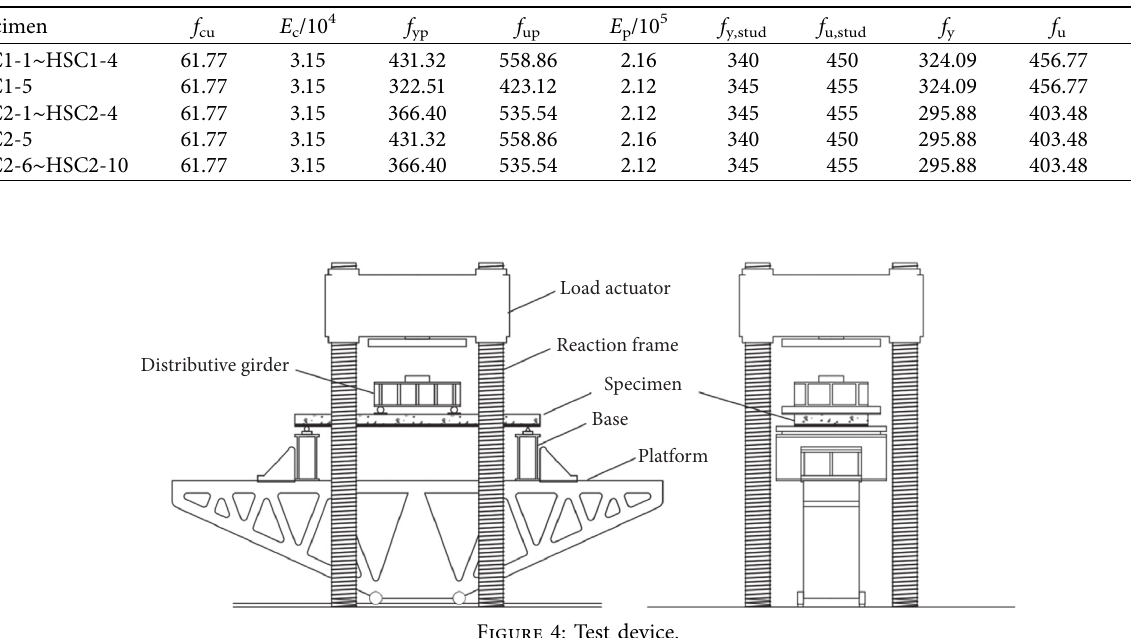
Table 2: Material properties of concrete and steel (N/mm 2 , mean value).